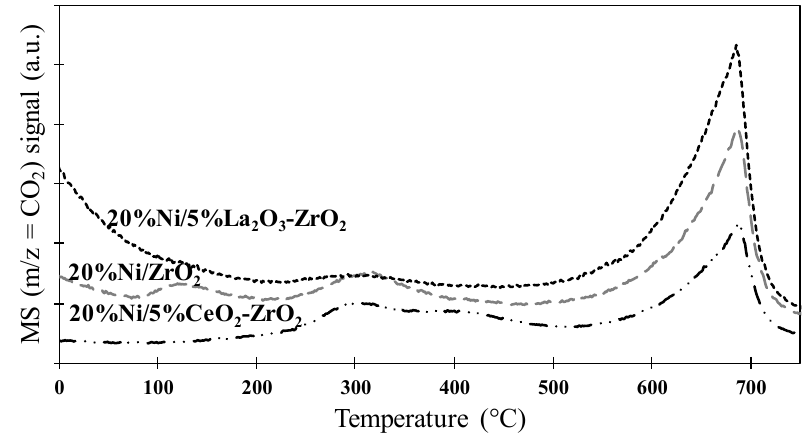
Figure 20. MS profiles for m/z = 44 (CO 2 ) obtained during the thermal analysis performed in an air atmosphere of the spent (after twelve hours of the oxy-steam reforming of LNG process at 700 °C, molar ratio between reagents was used: C:H 2 O:O 2 = 1:2.7:0.35, total gas flow 51 cm 3 /min) monometallic Ni catalysts supported on ZrO 2, 5%CeO 2 -ZrO 2 , or 5%La 2 O 3 -ZrO 2 oxides supports.